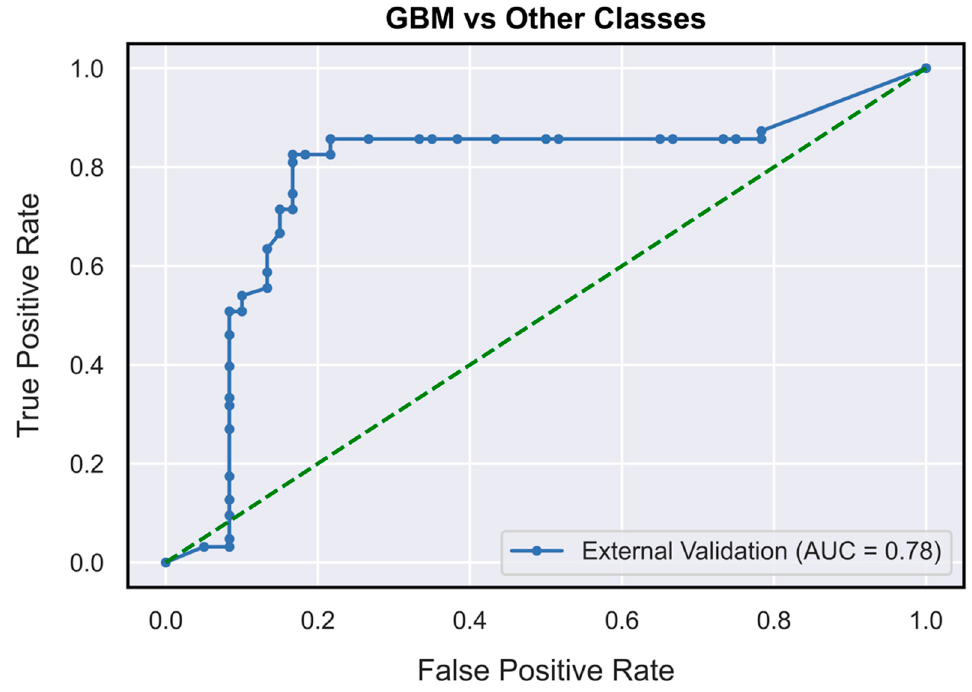
Figure 3. AUC-ROC curves (on TeS validation dataset) for glioblastoma diagnostic outcome class (OVR). GBM: glioblastoma; OVR: one-vs-rest.